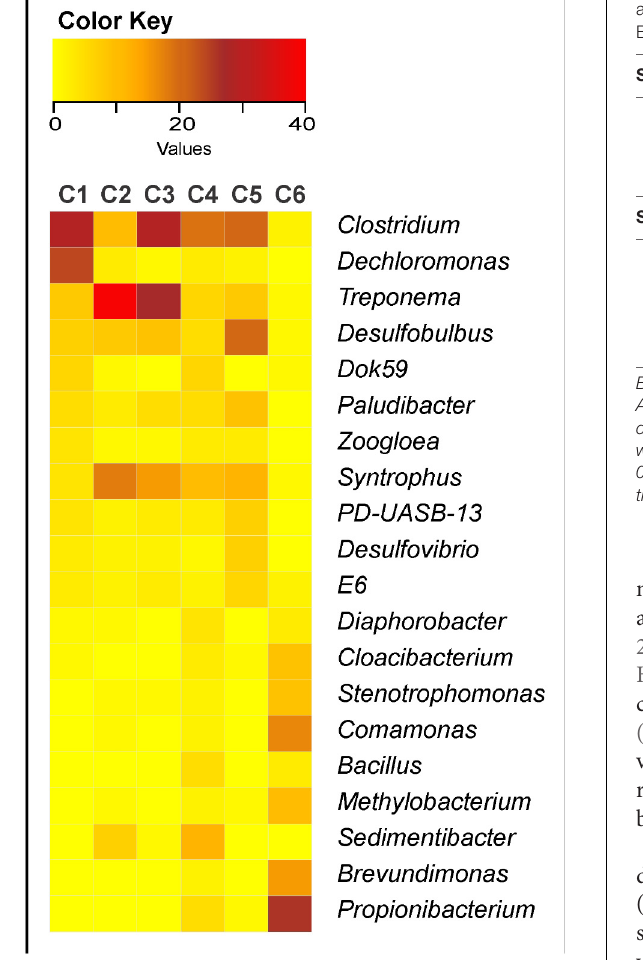
( Table 3 ) and diversity (Chao1, Simpson and Shannon) (Supplementary Table S3), at least not consistently, similarly